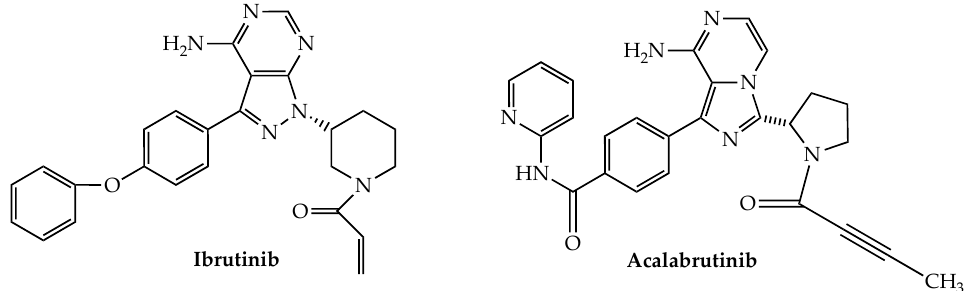
Figure 7. Bruton’s tyrosine kinase inhibitors with anti-myeloma activity.